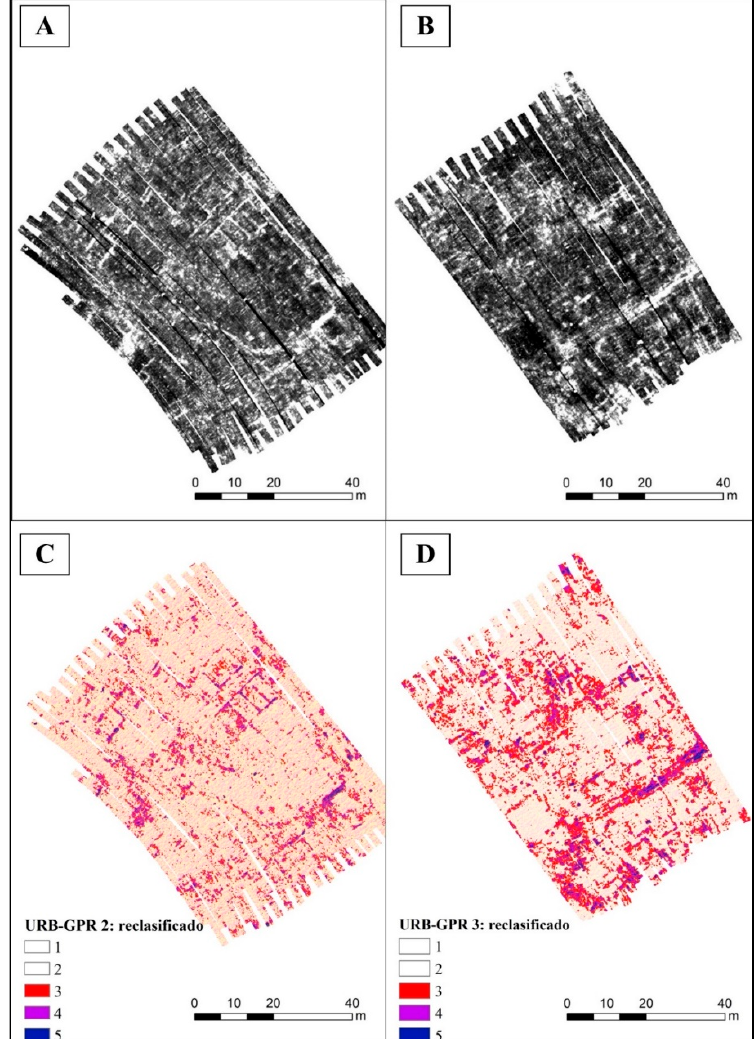
Figure 17. Post-processing and improving the visualisation of the data from projects 2 and 3 in the urban area: ( A ) Mean squared of project 2; ( B ) Mean squared of project 3; ( C ) Reclassification of project 2; ( D ) Reclassification of project 3.